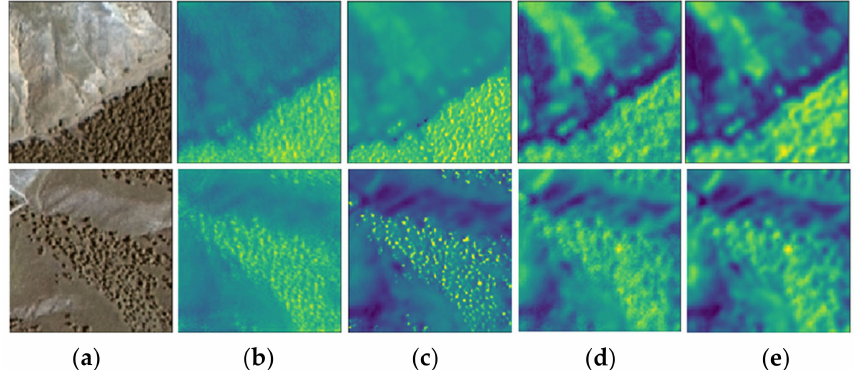
Figure 10. Figures of the high density plateau forest results: ( a ) false color composite image for sample visualization; ( b ) NDVI prediction; ( c ) NDVI ground truth; ( d ) RVI prediction; ( e ) RVI ground truth. The first row represents a high-density forest testing sample, and the second row represents a low-density forest testing